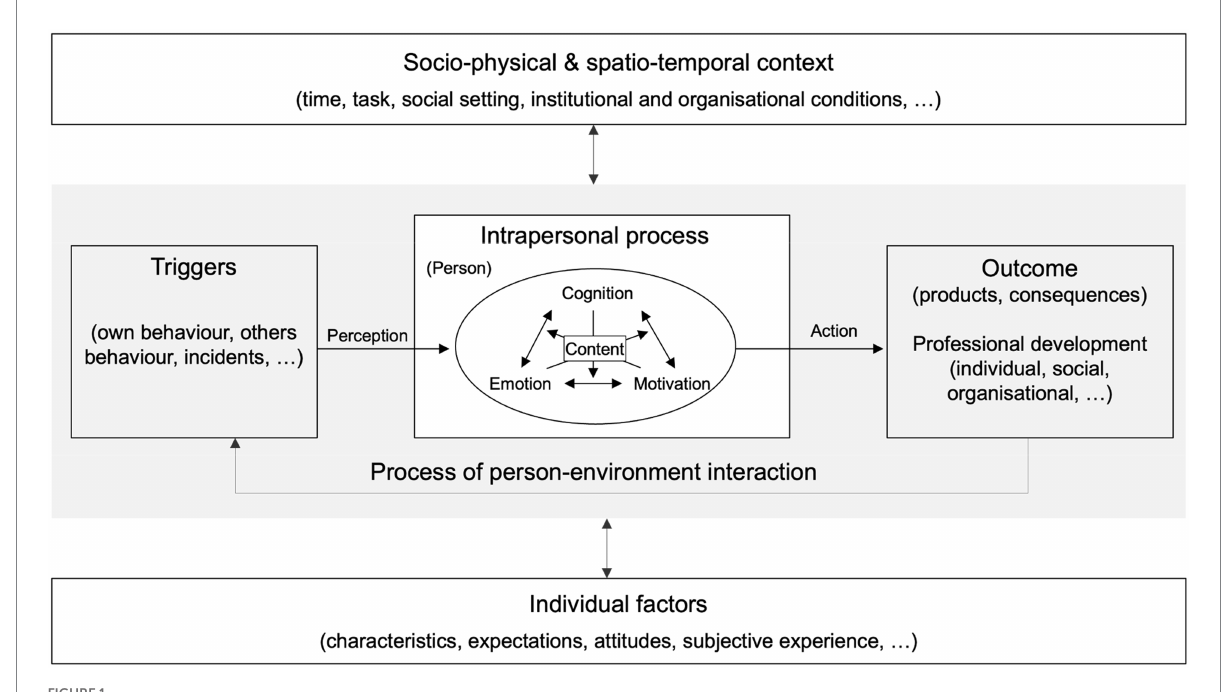
FIGURE 1 Conceptual model of reflection (adapted from Hommel et al., 2020, p. 2; based on Becker et al.,